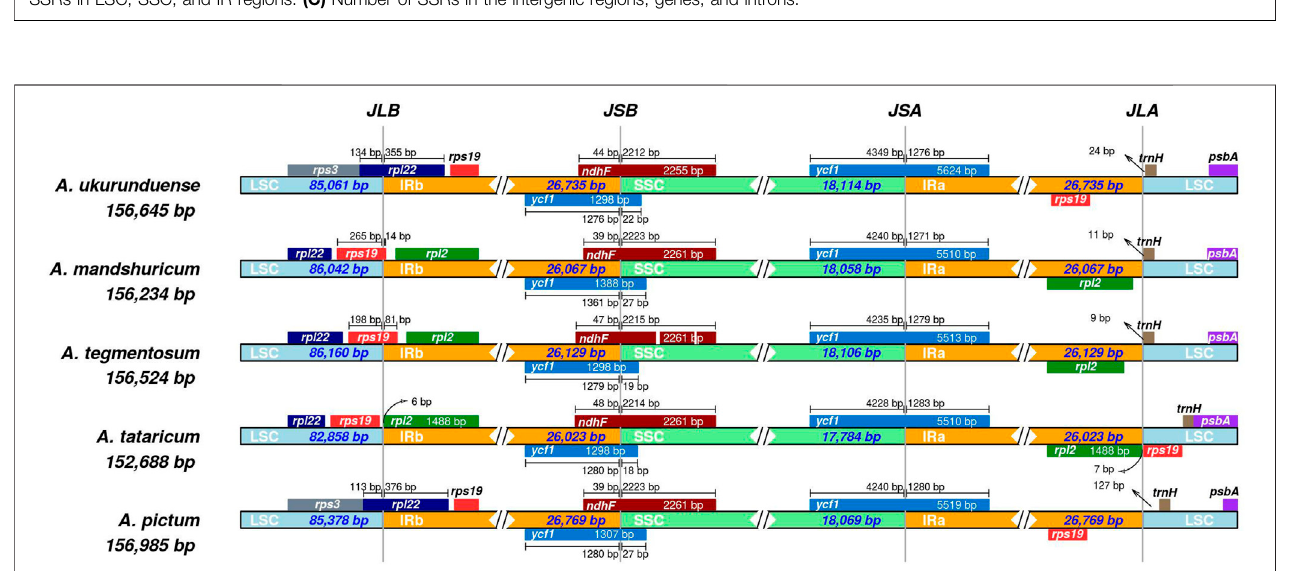
FIGURE4 | Number ofdifferenttypes ofSSRsfrom fi ve Acer species cp genomes. (A) Numberofdifferent SSRtypes detectedin fi ve cpgenomes. (B) Number of SSRs in LSC, SSC, and IR regions. (C) Number of SSRs in the intergenic regions, genes, and introns.